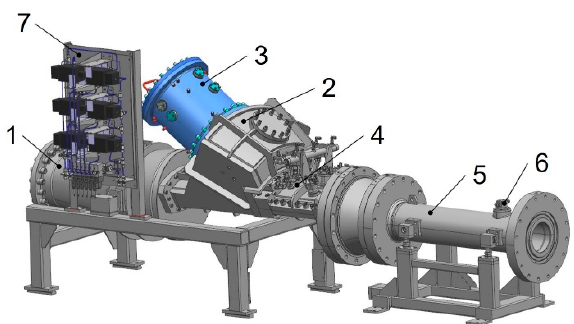
Figure 12. 3D model of the high-pressure test rig with the ACC can combustor. Numbers 1–7 are explained in the section describing the experimental facilities.